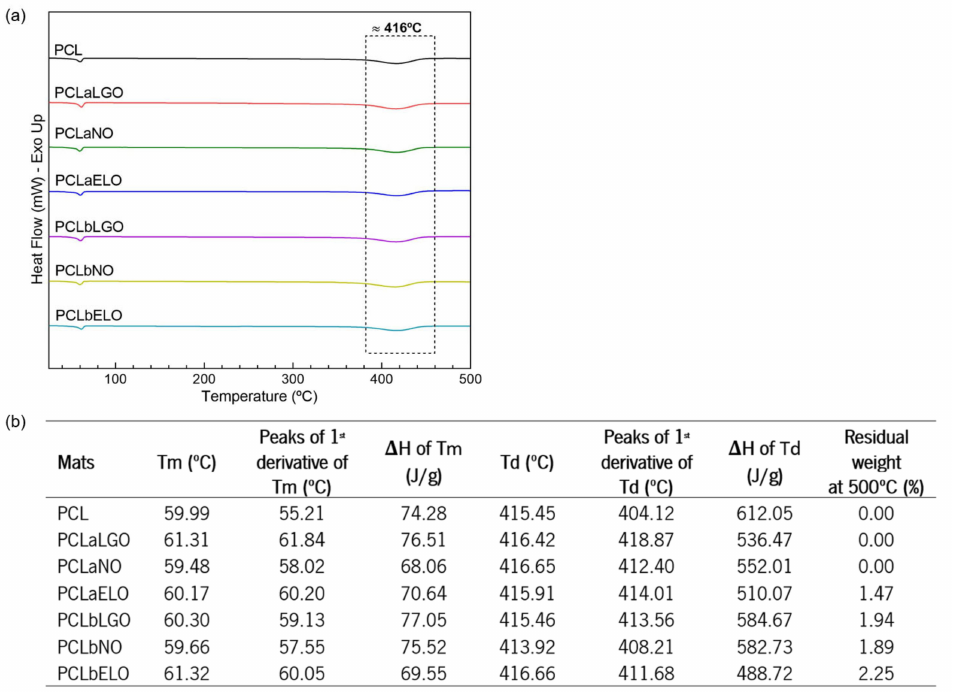
Figure 5. ( a ) DSC spectra of the PCL-based mats obtained from 25 to 500 ◦ C under nitrogen at- mosphere, flow rate of 200 mL/min and temperature rise of 10 ◦ C/min. ( b ) Main DSC thermal transitions ( Tm , melting temperature, Td , degradation temperature, and respective ∆ H , enthalpy change) and TGA data (1st derivative temperature peaks, and residual weight at 500 ◦ C), with n = 3 and S.D. <